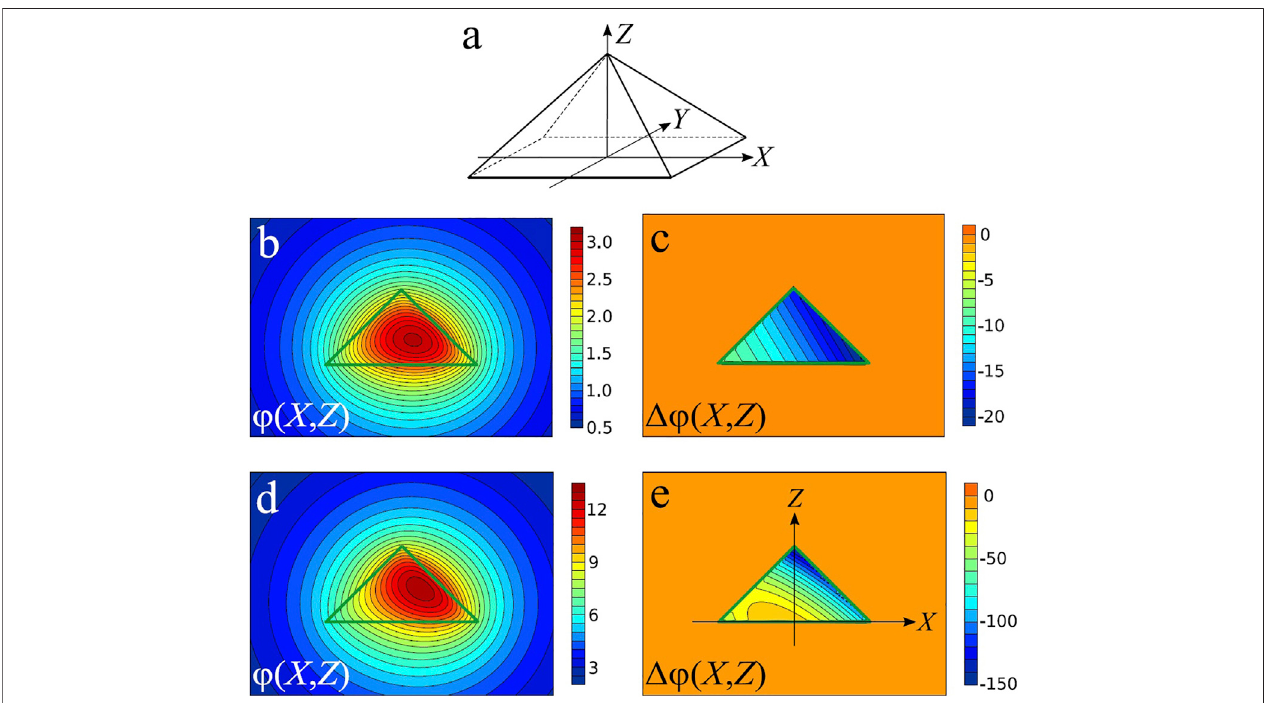
FIGURE3| Examplesofpotentialsofaninhomogeneouslychargedpolyhedron. (A) Anexampleofapolyhedron:apyramidwithheight h (cid:2) 1andlateralsize(length ofabaseedge) l (cid:2) 2. (B , C) Potential φ ( X , Z )anditsLaplacian Δ φ ( X , Z )inthecaseofanexponentialdensitydistribution ρ ( R ) (cid:2) exp( k · R )with k x (cid:2) 0.5, k y (cid:2) 0.4and k z (cid:2) 0.3. (D , E) Potential φ ( X , Z )anditsLaplacian Δ φ ( X , Z )inthecaseofaquadraticdensitydistribution ρ ( X , Y , Z ) (cid:2) 1+2 X +3 Y +4 Z +5 X 2 +6 Y 2 +7 Z 2 +8 XY +9 XZ +10 YZ .Plotsb, c,d,earepresented inthesectionbythe XZ -planethatpassesthroughthepyramidapex( Y (cid:2)